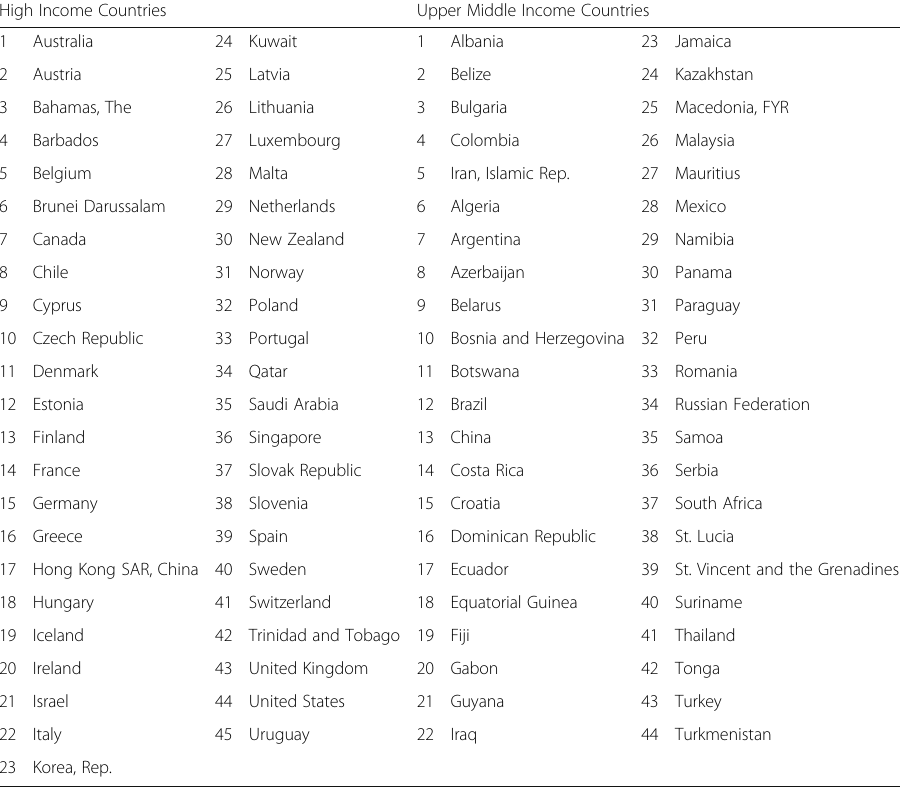
Table 9 List of developed